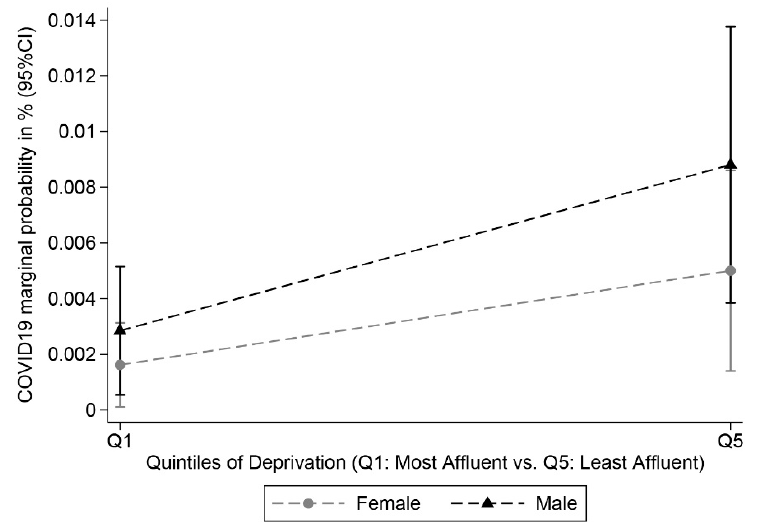
Figure 2. Probabilities of COVID-19 Testing Positive among UK Biobank Incident Cancer Patients by deprivation (most affluent vs. least affluent) and sex ( N = 18,917, 89 cases).